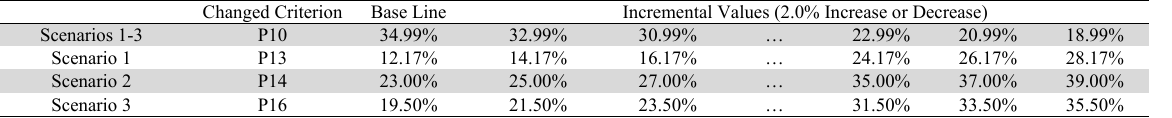
Sensitivity analysis of incremental values.